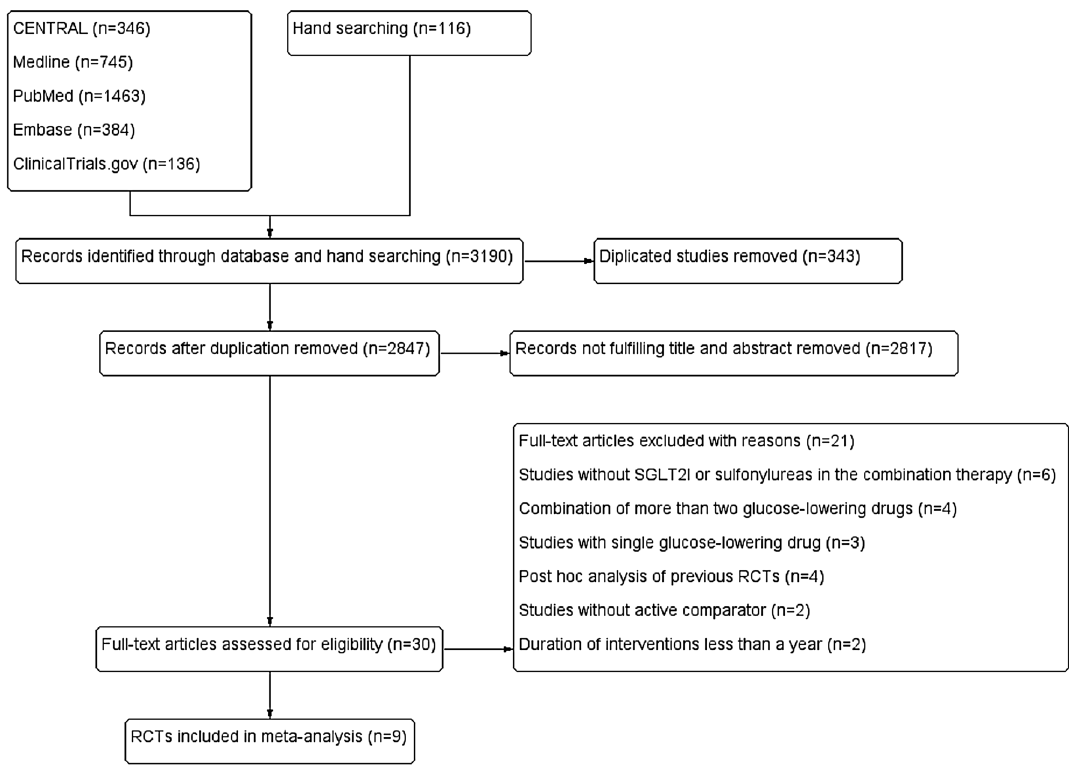
Figure 1. PRISMA flow diagram of the